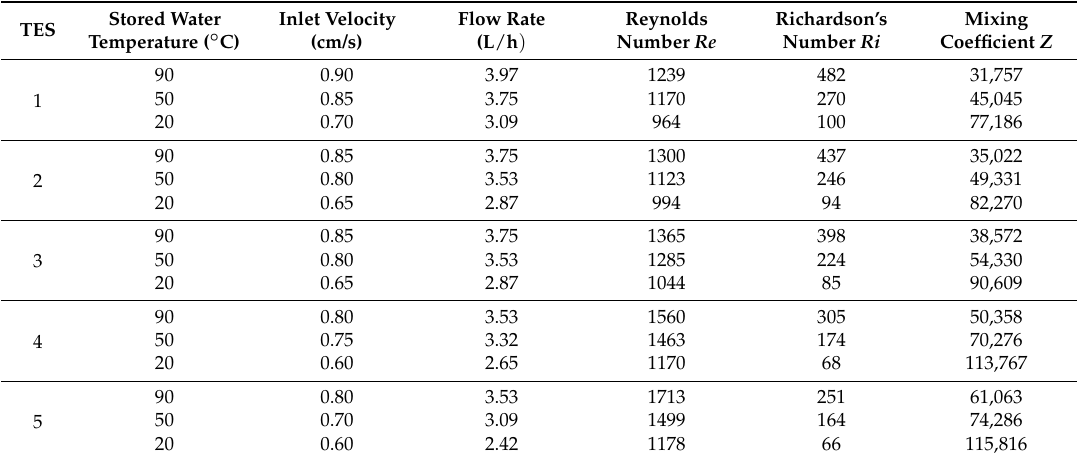
Table 2. Summary of the results: thermocline